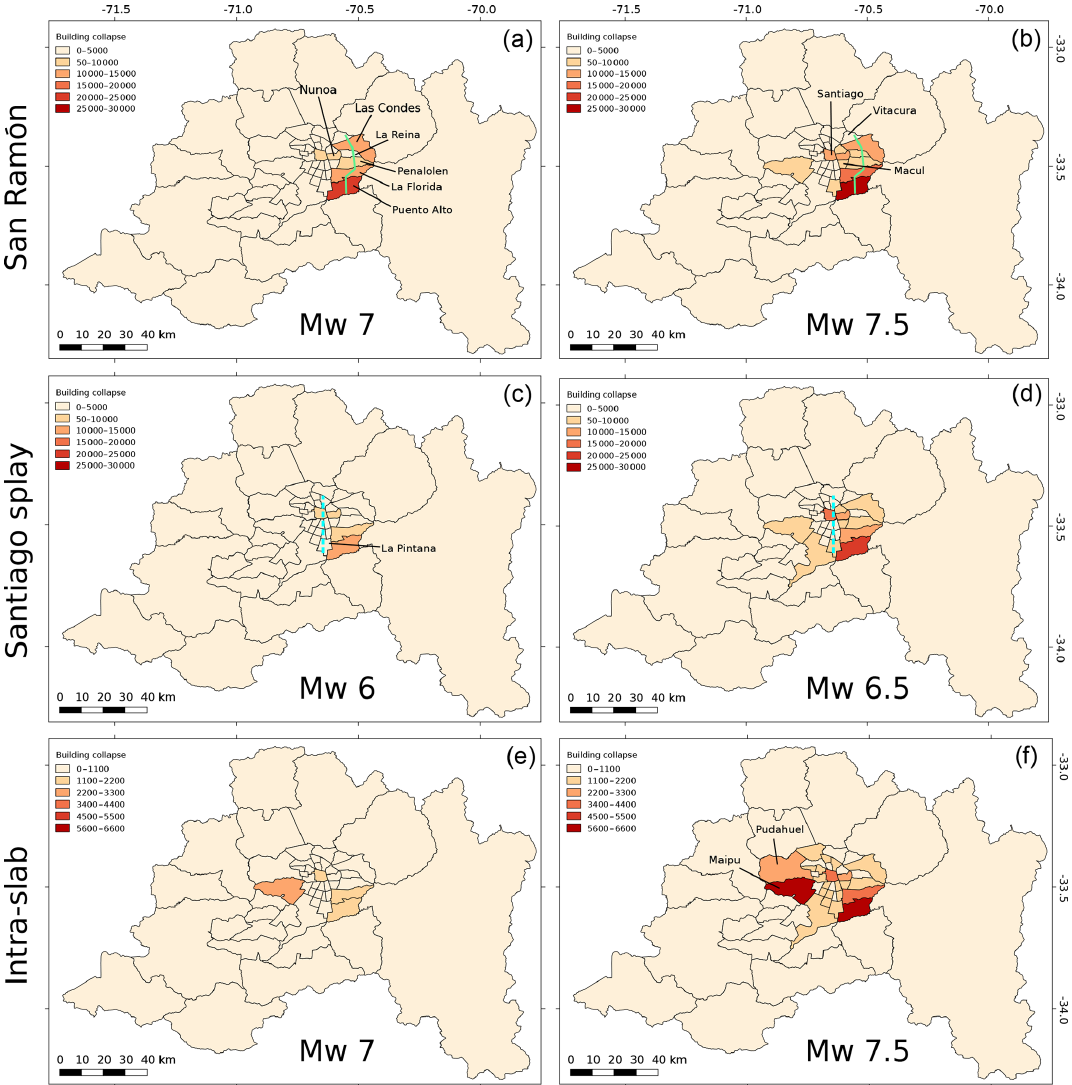
Figure 10. The distribution of collapsed buildings for the earthquakes considered in each set of magnitude pair scenarios for the San Ramón Fault (green line; a–b ), the Santiago splay fault (dashed cyan line; c–d ), and a deep intra-slab fault (e–f) . The collapse counts are the average for the GMPEs used in each calculation and include the total count of both complete and partial collapses. Note that the range of the colour scale changes between the upper four and lower two panels. The collapse fraction for each commune is given in the Supplement (Fig. S6). Names of all the communes are given in Fig.